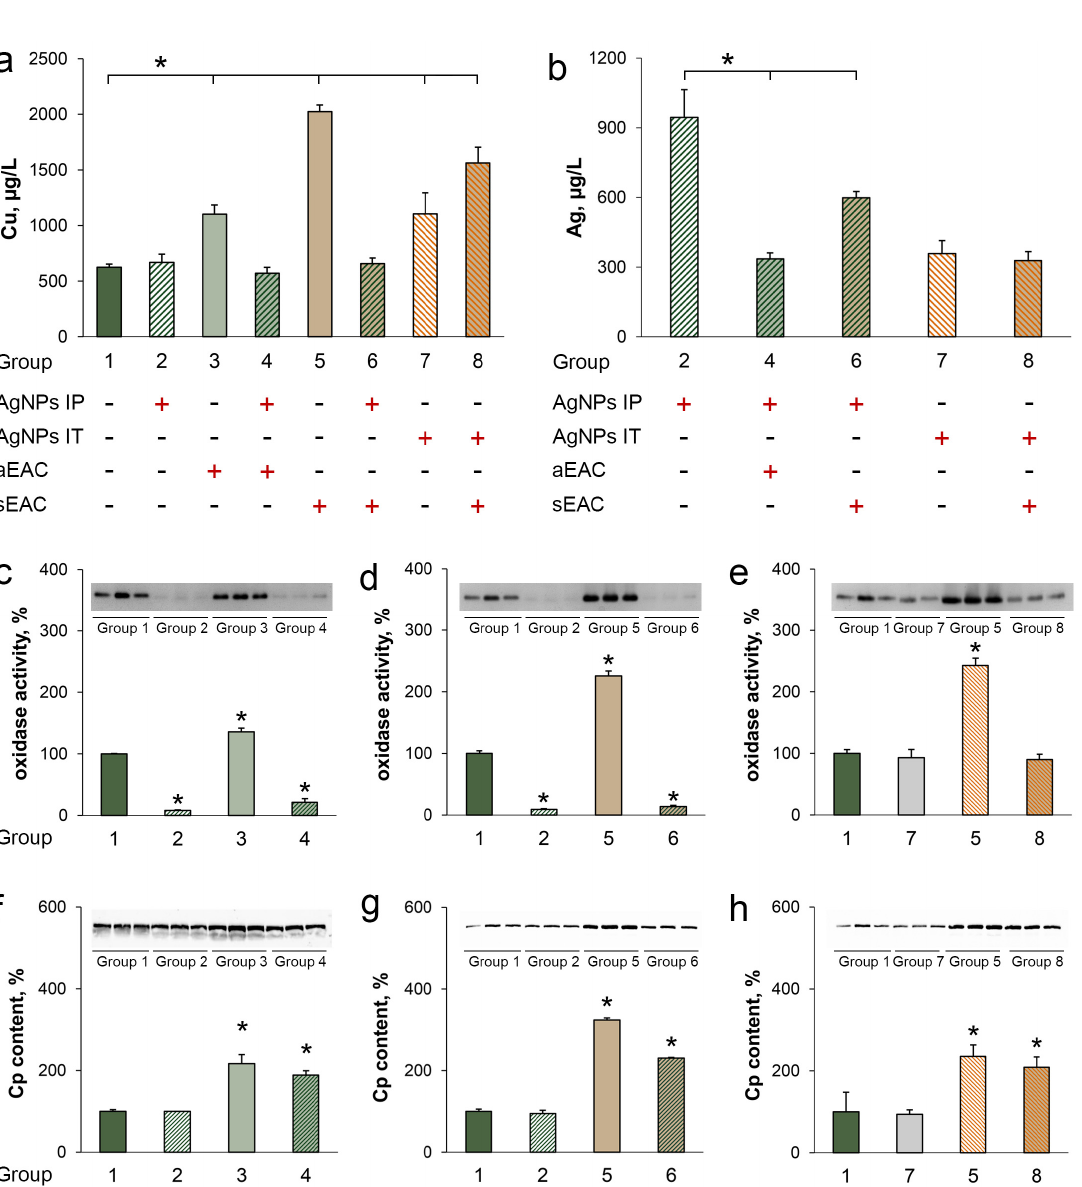
Figure 7. Influence of tumor growth and AgNP treatment on serum copper status indexes. The group numbering is given in Table 1. ( a ) Copper concentration; ( b ) Silver concentration; ( c − e ) Oxidase activity, insets − oxidase activity tested in gel with o − dianisidine; ( f − h ) Cp protein concentration measured by WB, insets − immunoblotting with antibodies to murine Cp. *: p < 0.5 compared to group 1 ( a , c − h ) and 2 ( b ).